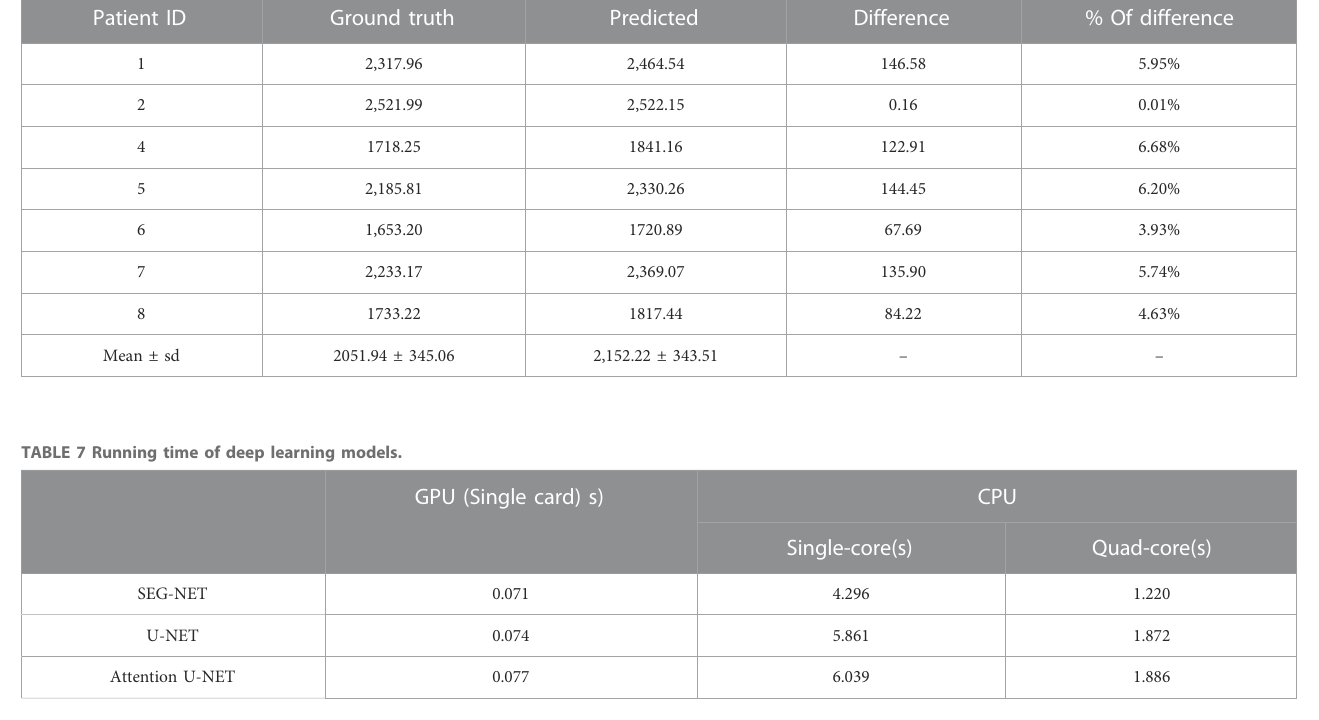
TABLE 6 Accuracy of the muscle volume calculation on the independent test set.